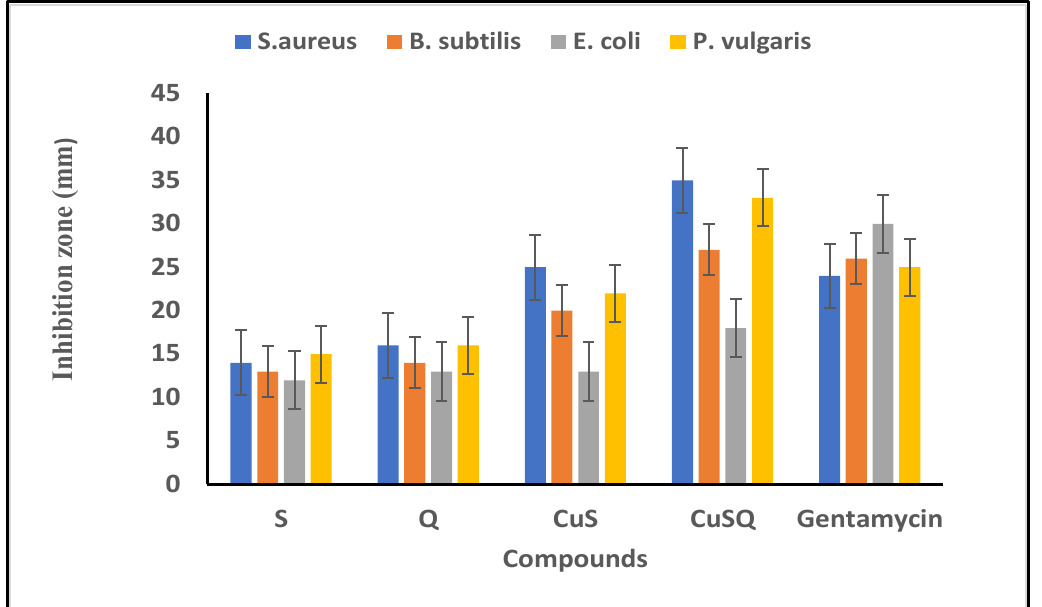
Figure 3. Antibacterial activity (inhibition zone) of Salen, CuS, S, Q, and CuSQ compared to gentamicin at concentration of 10 mg mL –1 .